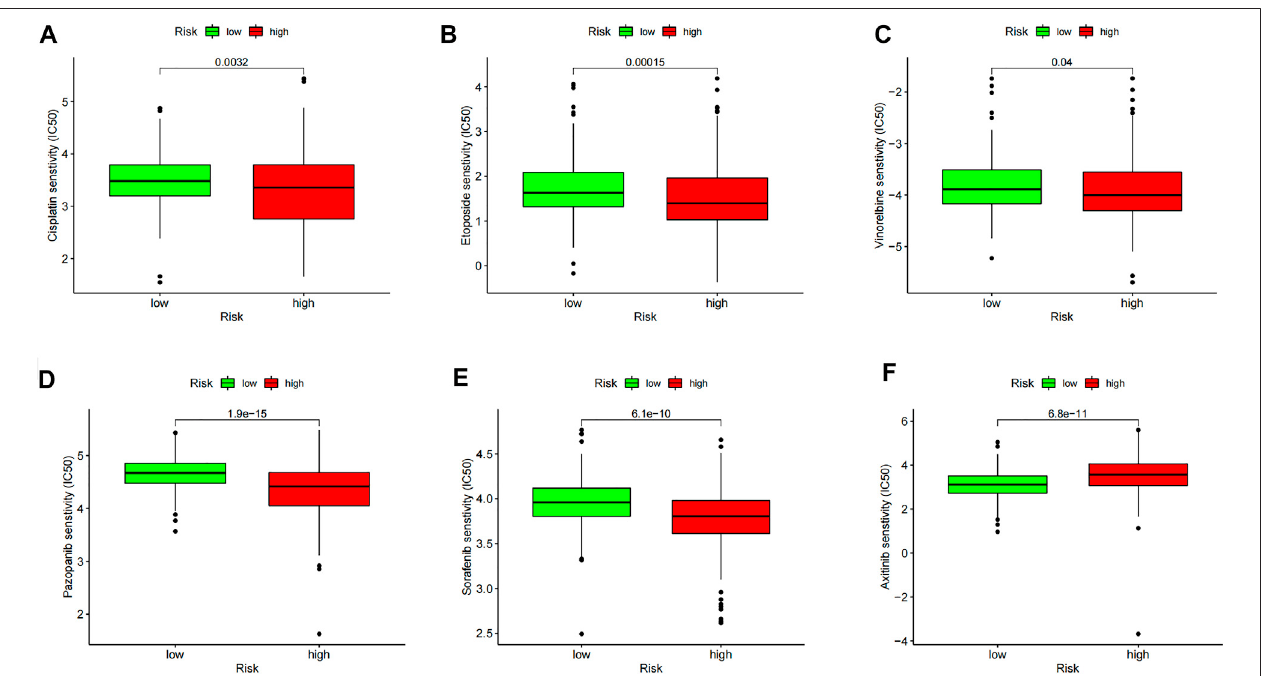
FIGURE 8 | Model drug sensitivity analysis based on the “ pRRophetic ” R package; LGG therapeutic drugs related to in fl ammation-related prognosis models are screened. The drug sensitivity of (A) Cisplatin, (B) Etoposide, (C) Vinorelbine, (D) Pazopanib, (E) Sorafenib, and (F) Axitinib in High and Low Risk Groups respectively.